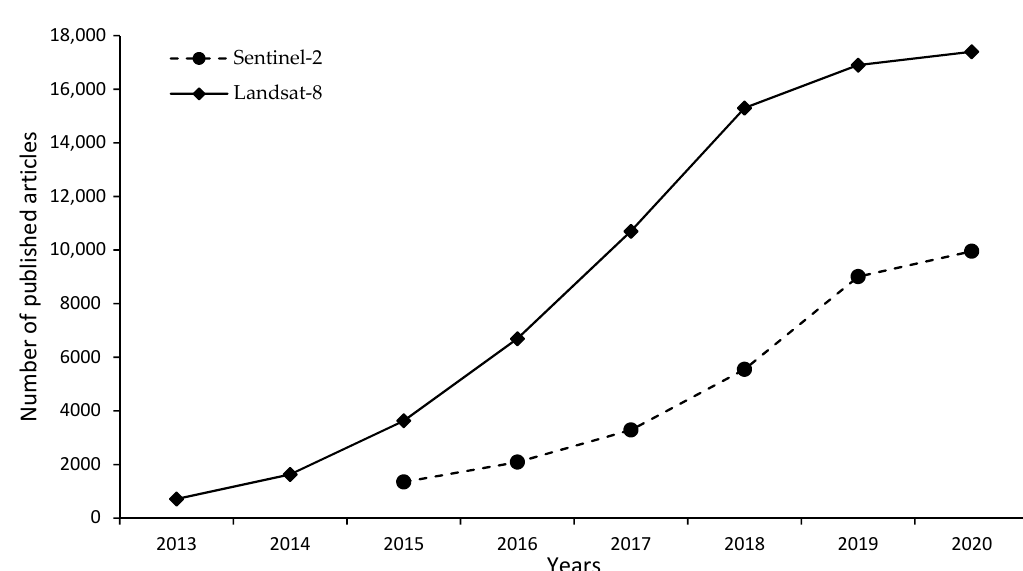
Figure 2. The general trends of articles published from 2015 to 2020 based on the accumulative number of published articles. Note that Sentinel ‐ 2 was launched in 2015, while Landsat ‐ 8 was launched in 2013.